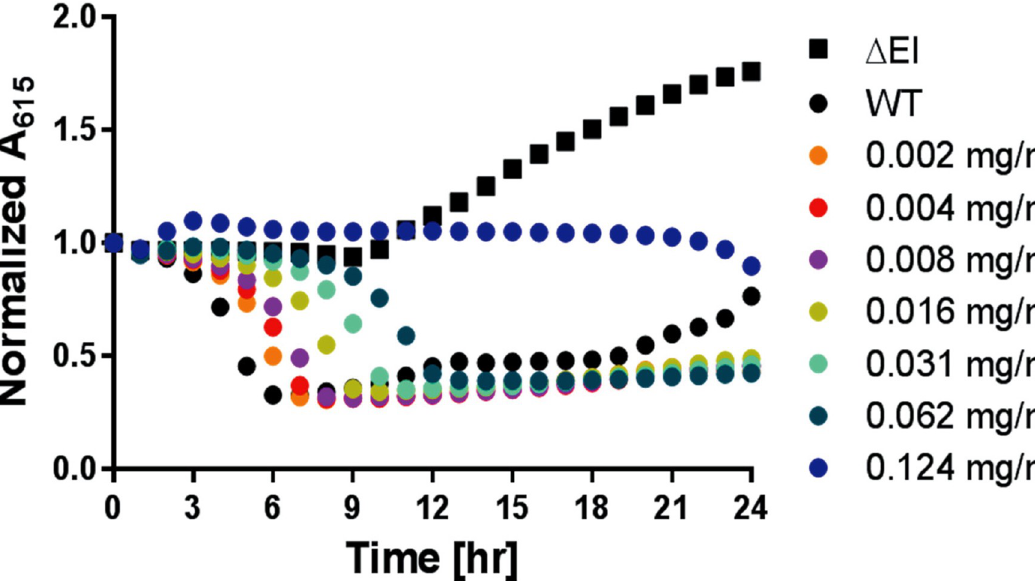
Fig 2. Impact of MW01 on sucrose fermentation by V . cholerae . Assays were carried out at 30˚C in pH-MM Suc and microtiter plates. Absorbance measurements (A 615 ) reflect the ability of bacterial cells to transport and ferment sucrose. The result of one representative experiment is shown. Data are shown for a PTS mutant ( Δ EI) negative control, a wild-type V . cholerae (WT) positive control, and WT in the presence of the compound. Bacteria were exposed to MW01 at concentrations varying from 0.002- to 0.124-mg/mL. Conditions were tested in triplicate in each experiment, and three experimental replicates were performed on separate days. To account for the variability of initial absorbance measurements, experimental data were normalized to the initial A 615 for each well.